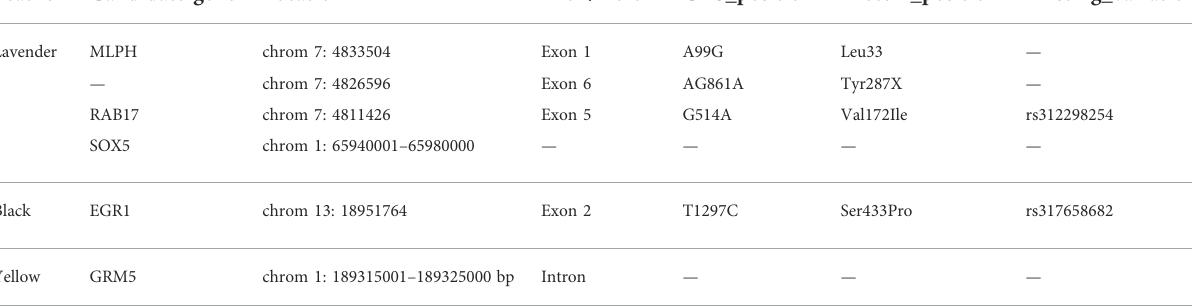
TABLE 1 Candidate genes based on the SNPs and amino acid substitutions in chicken with black/lavender/yellow plumage .